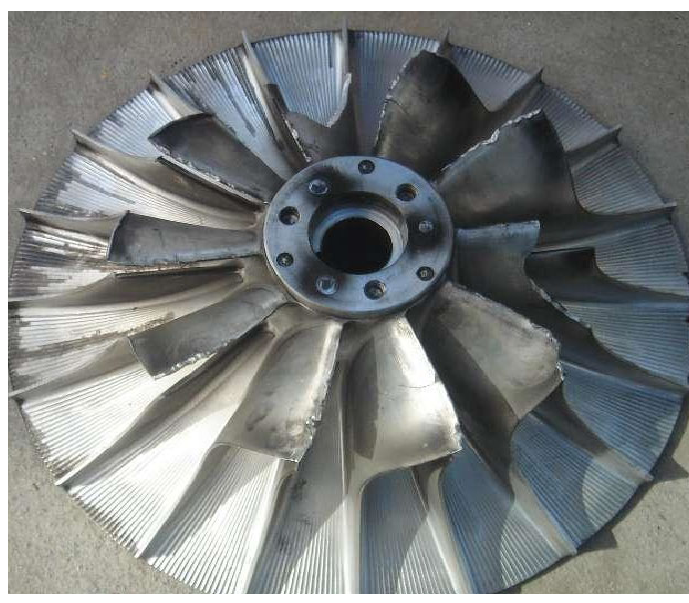
Figure 16. Fatigue fracture of